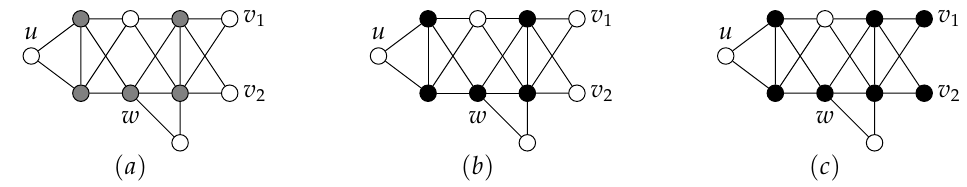
Figure 2. ( a ) Grey vertices are neighbors of vertices of degree 2. ( b ) Minimum total 2-dominating set and ( c ) minimum global total 2-dominating